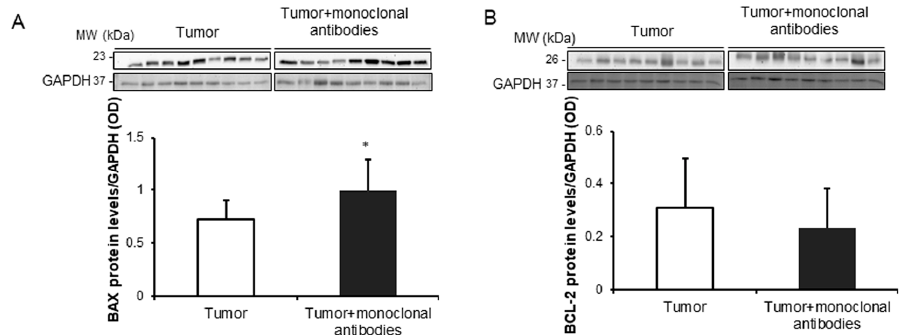
Figure 6. ( A ) Representative immunoblots and mean values and standard deviation of BAX protein levels/GAPDH in subcutaneous tumors of lung cancer mice as measured by optical densities. ( B ) Representative immunoblots and mean values and standard deviation of BCL-2 protein levels/GAPDH in subcutaneous tumors of LC mice as measured by optical densities. Representative GAPDH is shown as the loading control. Statistical significance is represented as follows: *: p ≤ 0.05 between non-treated controls ( N = 9) in white bars and treated lung cancer (N = 9) mice in black bars. Definition of abbreviations: BAX, BCL-2 associated X protein; BCL-2, b-cell lymphoma 2; GAPDH, glyceraldehyde-3-phospate dehydrogenase; OD, optical densities.